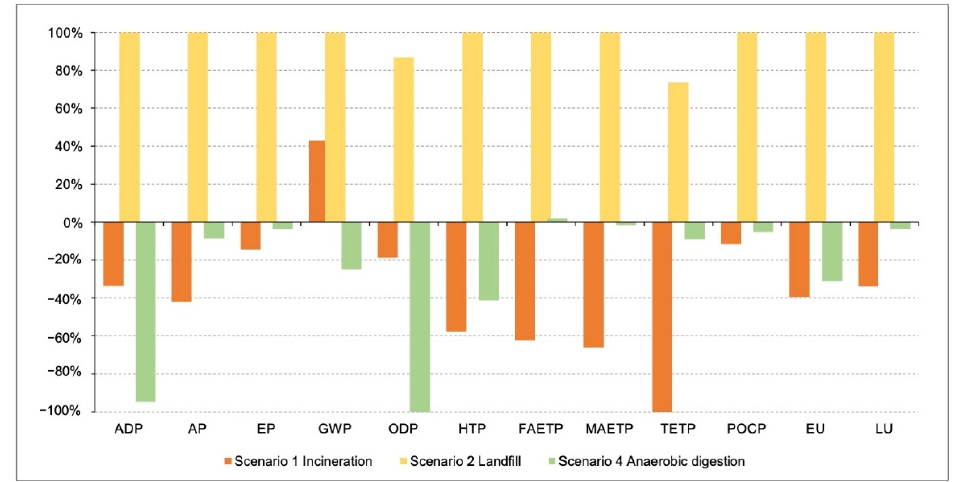
Figure 3. Comparison among the energy-recovery scenarios with considering the avoided products. The functional unit used was 1 metric ton of KW. The characterization factors are: Abiotic Depletion (ADP), Acidification (AP), Eutrophication (EP), Global Warming (GWP), Ozone Layer Depletion (ODP), Human Toxicity (HTP), Fresh Water Aquatic Ecotoxicity (FAETP), Marine Aquatic Ecotoxicity (MAETP), Terrestrial Ecotoxicity (TETP), Photochemical Oxidation (POCP), Land use